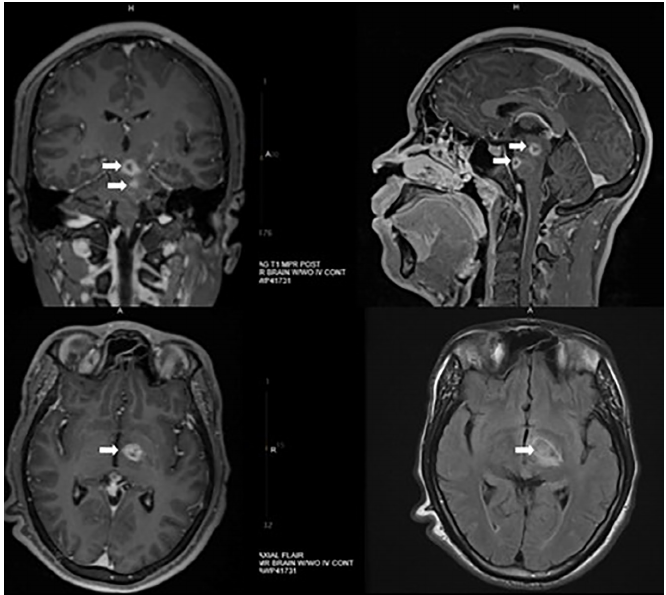
Image. Magnetic resonance imaging of the brain with/without intravenous contrast: multifocal abnormal enhancing lesions (white arrows) in the bilateral cerebral hemispheres, left thalamus, and